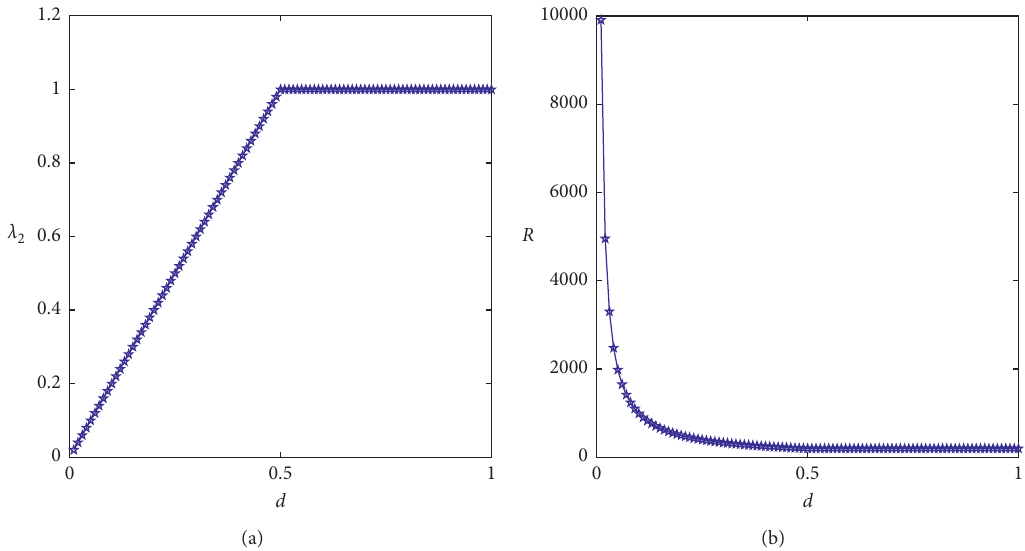
Figure 13: When N is odd, the synchronizability of Network II changes with the interlayer coupling strength d of the leaf nodes. (a) λ changes with d ( d changes from 0.01 to 1); (b) R changes with d ( d changes from 0.01 to 1).